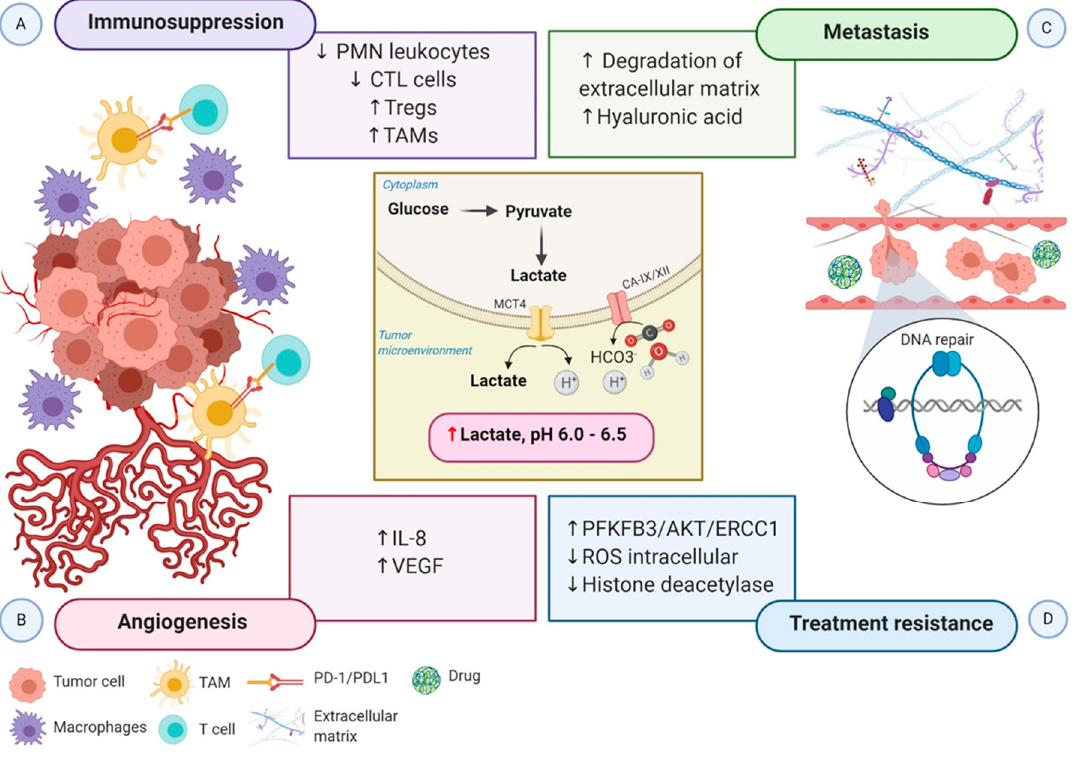
Figure 3. Schematic representation of the impact of hypoxia-associated metabolic reprogramming in tumor progression. The increased production of lactate along with the overexpression of CA-IX and CA-XII are regulated by HIF-1 α directly, promoting the acidification of the tumor microenvironment. ( A ) The acidic microenvironment decreases the proliferation of polymorphonuclear leukocytes and CTL cells and increases the recruitment of Tregs cells. Moreover, the secretion of cytokines and chemokinesattractsmonocytes, enablingthemtodi ff erentiateintomacrophagesorTAMs. TAMsexpress ligand-receptor PD-L1 that inhibits T cells cytotoxic function, and macrophages induce inflammation. Altogether, these mechanisms generate an immunosuppressive tumor microenvironment. ( B ) Elevated lactate in the tumor microenvironment boosts IL-8 and VEGF to facilitate angiogenesis. ( C )